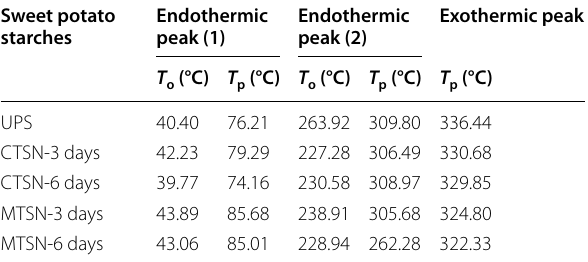
onset temperature ( T o ), peak =